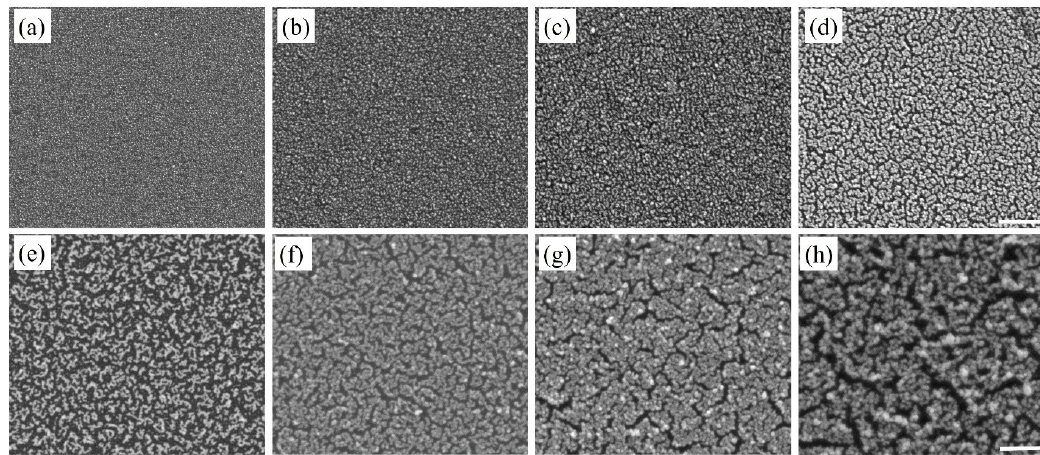
Figure 5. SEM images of Au nanostructures deposited on Si substrate after ( a ) first, ( b ) second, ( c ) third, ( d ) fourth, ( e ) fifth, ( f ) sixth, ( g ) eighth, and ( h ) tenth deposition cycle with CTAB added as surfactant. The scale bar is 500 nm.